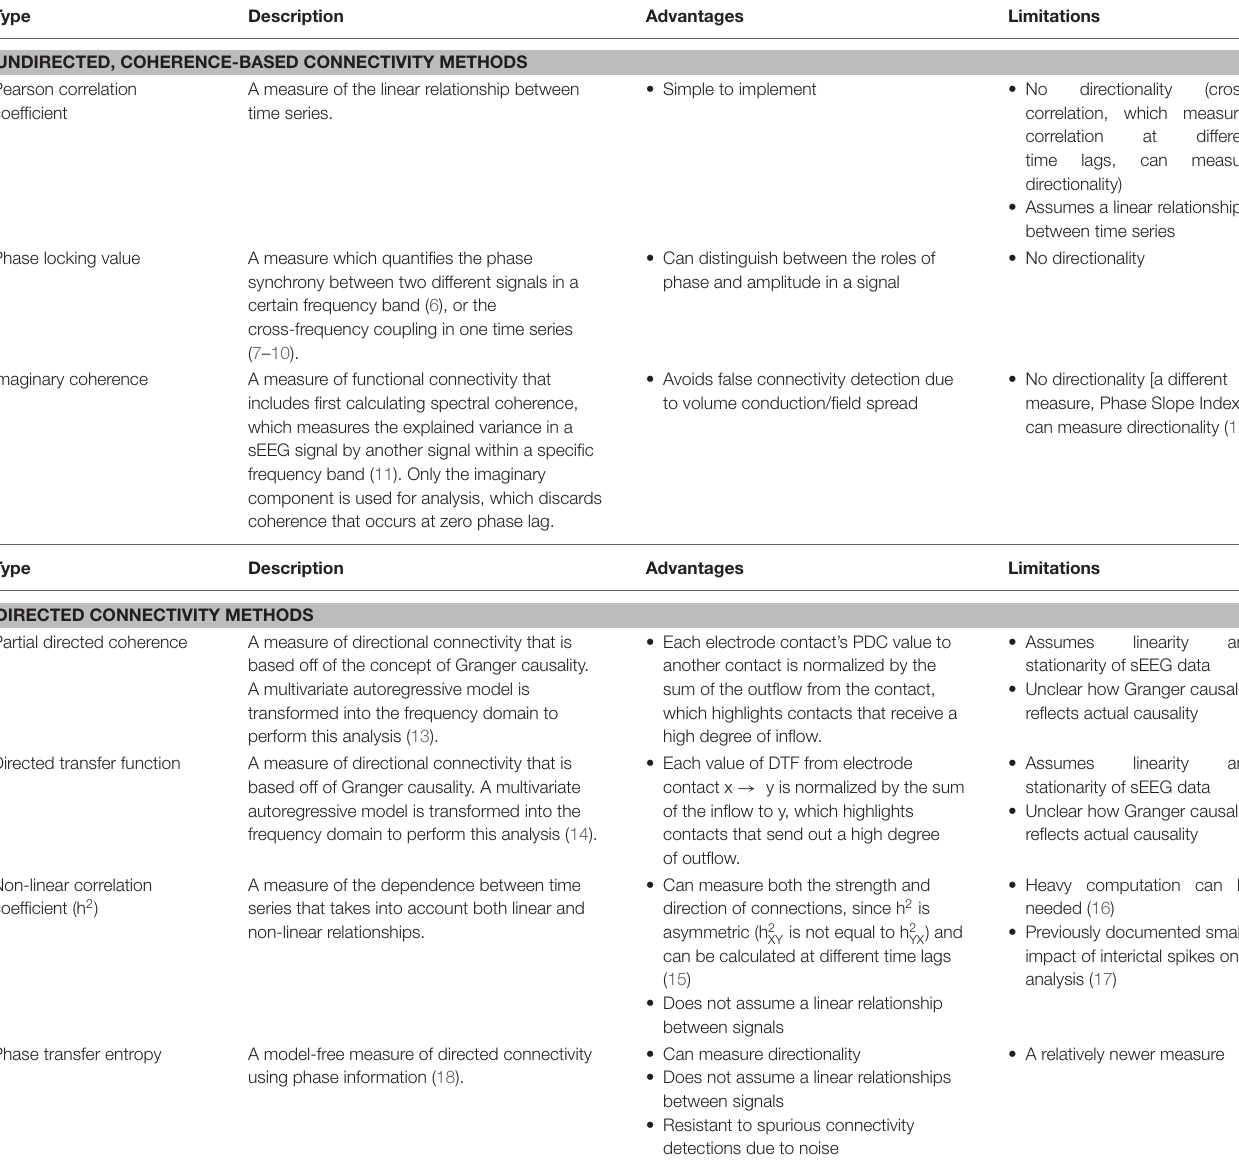
TABLE 1 | sEEG functional connectivity methods and their advantages and